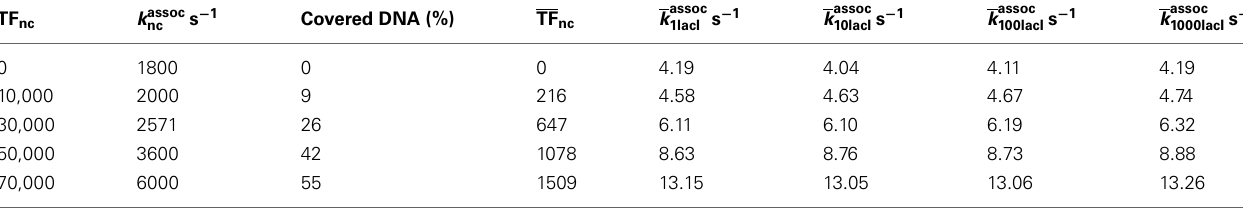
Table 1 | Sub-system parameters for various non-cognate molecule abundances. TF nc k assoc nc s − 1 Covered DNA (%) TF